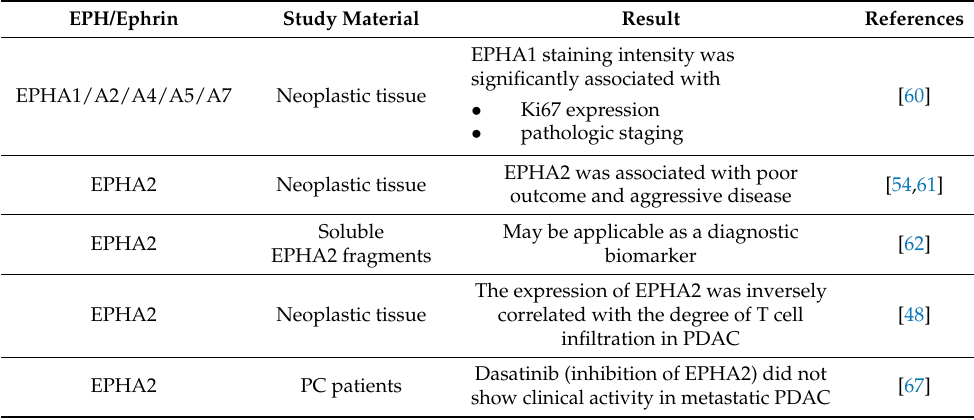
Table 1. Published clinical data regarding the EPH/ephrin signaling